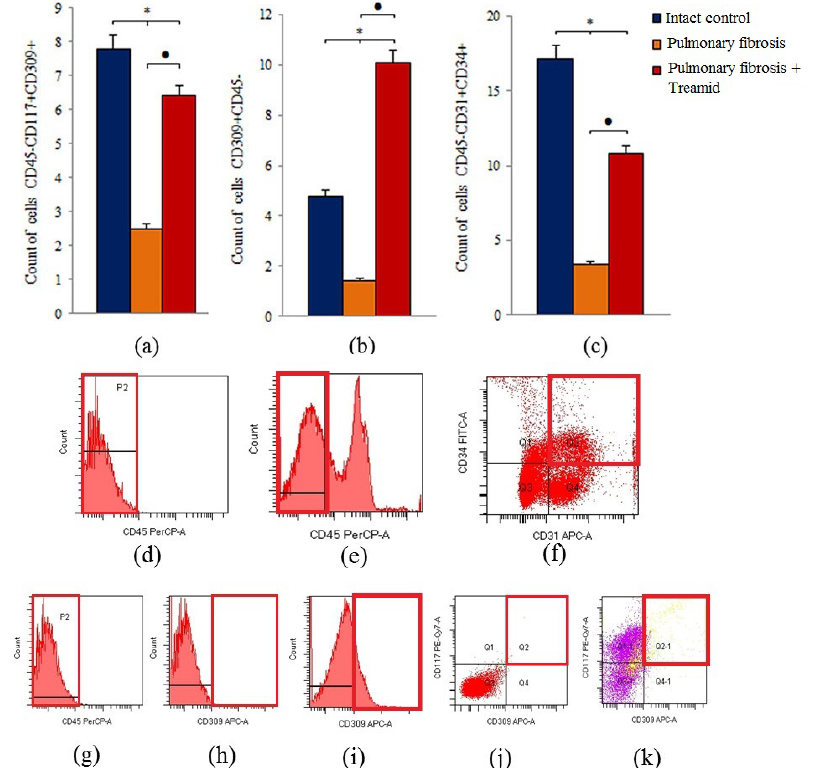
Figure 3. Characterization of CD45 − CD117 + CD309 + , CD309 + CD45 − , CD45 − CD31 + CD34 + endothelial cell population isolated from lung of male C57BL / 6 mice on d21. Cells were analyzed by flow cytometry using antibodies for mouse CD45, CD31, CD34, CD117, CD309. Dot plots are representative for three independent experiments with the mean from three independent experiments. ( a ) The content of angiogenesis progenitors (CD45 − CD117 + CD309 + ) in the lung of mice. ( b ) The content of endothelial cells (CD309 + CD45 - ) in the lung of mice. ( c ) The content of endothelial progenitor cells with phenotype CD45 - CD31 + CD34 + in the lung of mice. Groups: control, pulmonary fibrosis and pulmonary fibrosis treated by Treamid. * Significance of difference compared with intact control ( p < 0.05); ● significance of difference compared with the pulmonary fibrosis group ( p < 0.05). ( d ) Isotype control for IgG2a (PerCP). ( e ) Phenotype establishment and qualitative analysis of CD45 (PerCP). ( f ) Phenotype establishment and qualitative analysis of CD34 (FITC), CD31 (APC). ( g ) Isotype control for IgG2a (PerCP). ( h ) Isotype control for IgG2b (APC). ( i ) Phenotype establishment and qualitative analysis of CD309 (APC) expression. ( j ) Isotype control for IgG2b (PE-Cy7) and for IgG2b (APC). ( k ) Phenotype establishment and qualitative analysis of CD117 and CD309 (APC) expression. 2.5. The Effect of Treamid on CD31 + Cells In Vitro Angiogenesis is a physiological process that maintains organ homeostasis. In contrast, dysregulated neovascularization is involved in pathological conditions such as pulmonary fibrosis. We observed an increase in the number of apoptotic CD31 + cells in culture of cells isolated from mice with pulmonary fibrosis compared to cells isolated from group 1 mice (Figure 4b). The effects of Treamid on CD31 + cells were studied on cells isolated from lungs of groups 1 and 3. We found that Treamid significantly reduced the number of apoptotic CD31 + cells in group 3 (Figure 4b, 3.9 times p < 0.05) but had no significant effects on the number of apoptotic CD31 + cells in group 1. Treamid increased the number of CD31 + cells with active esterases in group 3 (by 58% compared to control culture, p < 0.05) (Figure 4a). A similar effect was observed in group 1.